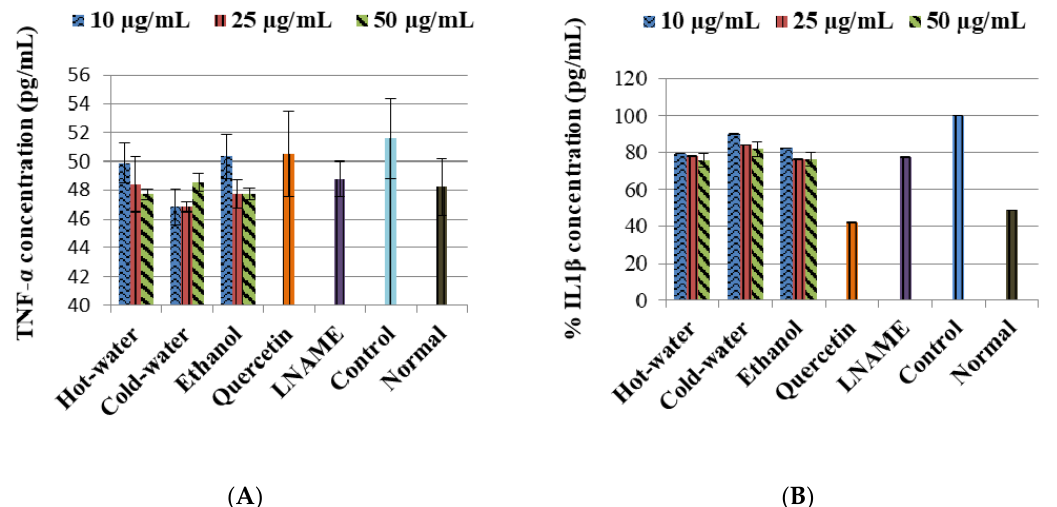
Figure 3. Effects of P. natalensis extracts on LPS-induced TNF- α ( A ) and IL1 β ( B ) production in RAW 264.7 macrophages treated with different concentrations (10, 25 and 50 µg/mL), and positive controls quercetin (50 µg/mL) and LNAME (100 µM) over 24 h.